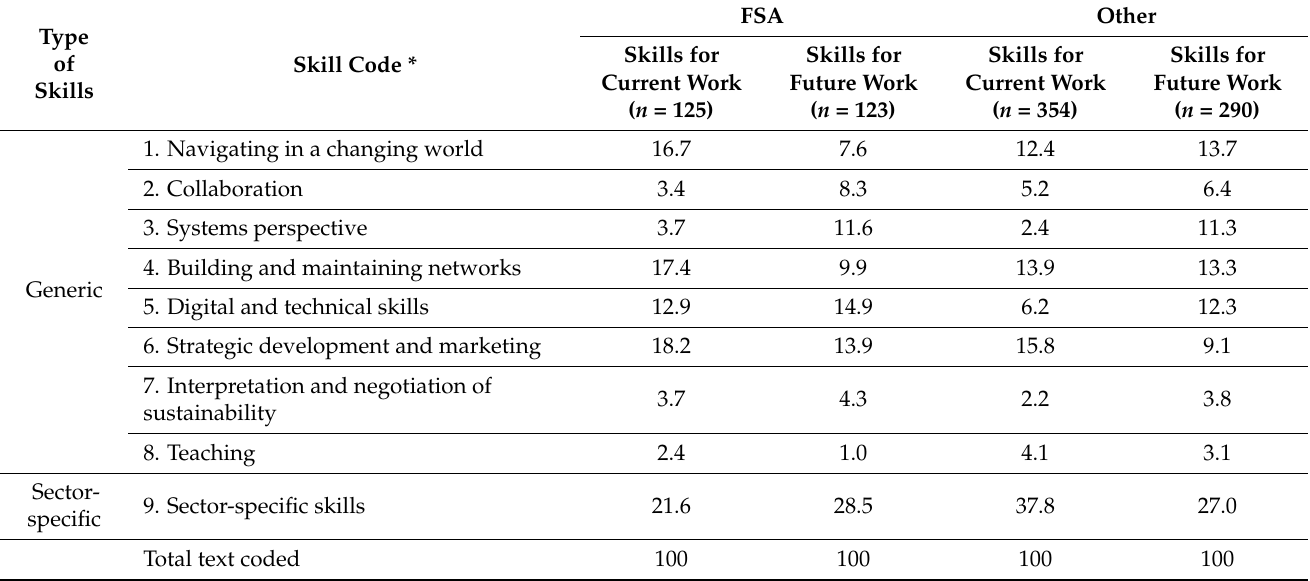
Table 3. Percentage of text coded to each skill for current and future work,